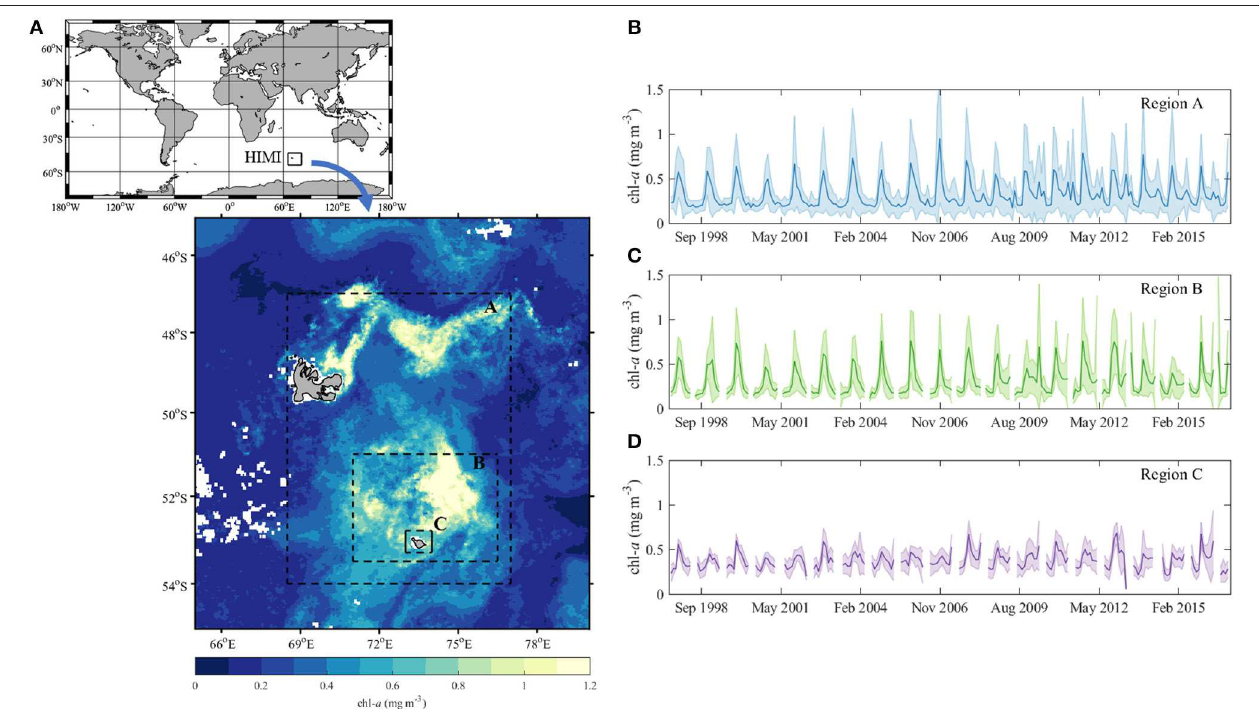
FIGURE 1 | Variability of chlorophyll a concentration (chl- a ) on the Kerguelen Plateau; (A) average chl- a in January 2013; Average chl- a between September 1997 and December 2015 in areas A, B, and C marked by dashed rectangles are presented in plots (B–D) , respectively. The lines are the average chl- a and the shaded areas reflect the average ± 1 standard deviation. Pixels with no data are marked in white. All plots prepared with the use monthly OC-CCI data (http://www.esa-